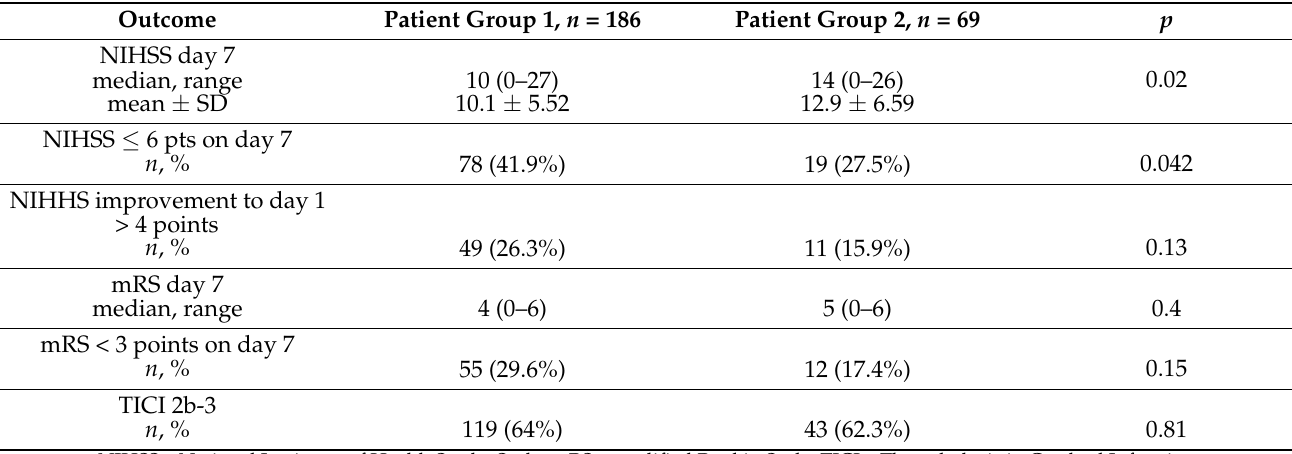
Table 2. Comparison of clinical and radiological outcomes after endovascular treatment between Patient Group 1 and Patient Group